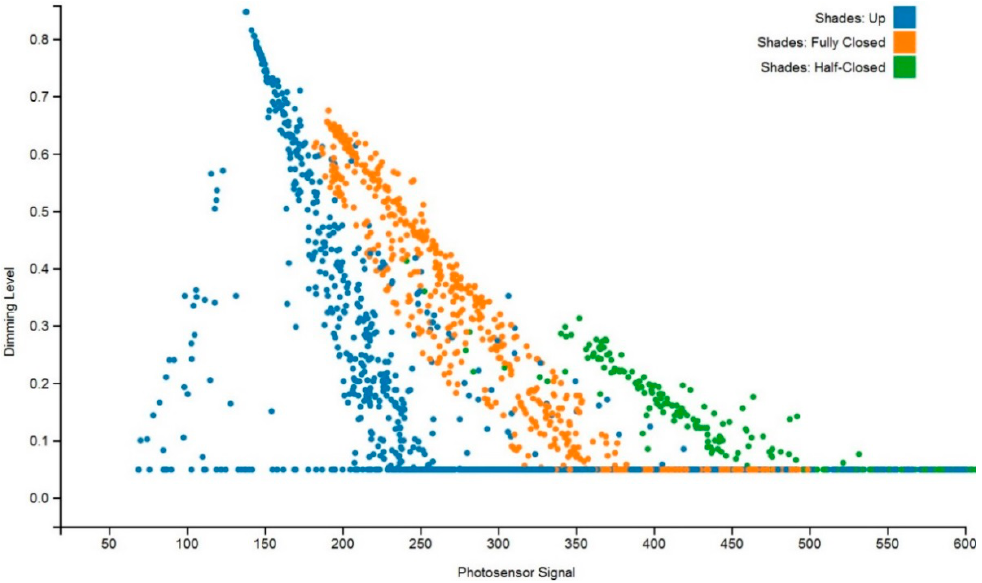
Figure 6. A scatter plot showing the optimum dimming level and the associated signal that would be received at a photosensor with a given spatial sensitivity and mounting position. The color of the dot represents the shading condition at that particular hour.